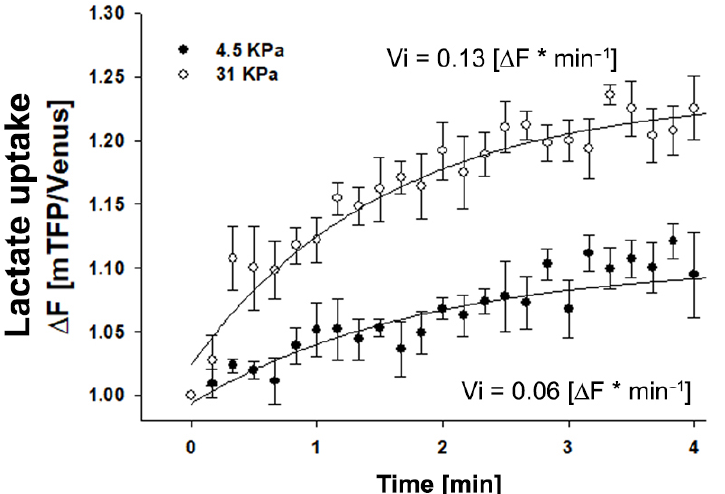
Figure 4. Lactate transport is favored in mammary MDA MB-231 cells cultured in rigid matrices. Time course curve of lactate incorporation in MDA MB-231 cells measured as the fluorescence ratio of a LACONIC biosensor. Cells were cultivated for 4 days on coverslips coated with an elastic polyacrylamide gel to which type I collagen was covalently cross-linked, and then exposed to 5 mM lactate. Fluorescence was recorded every 10 sec. Open circles correspond to cells cultured on a soft matrix (4.5 KPa), and closed circles to cells cultured on a stiffer matrix (31 KPa). The data correspond to an average of three single cells recorded in two independent experiments. The continuous line represents the best fit of a double rectangular hyperbola, and Vi values were estimated from the slope of each lactate uptake curve.